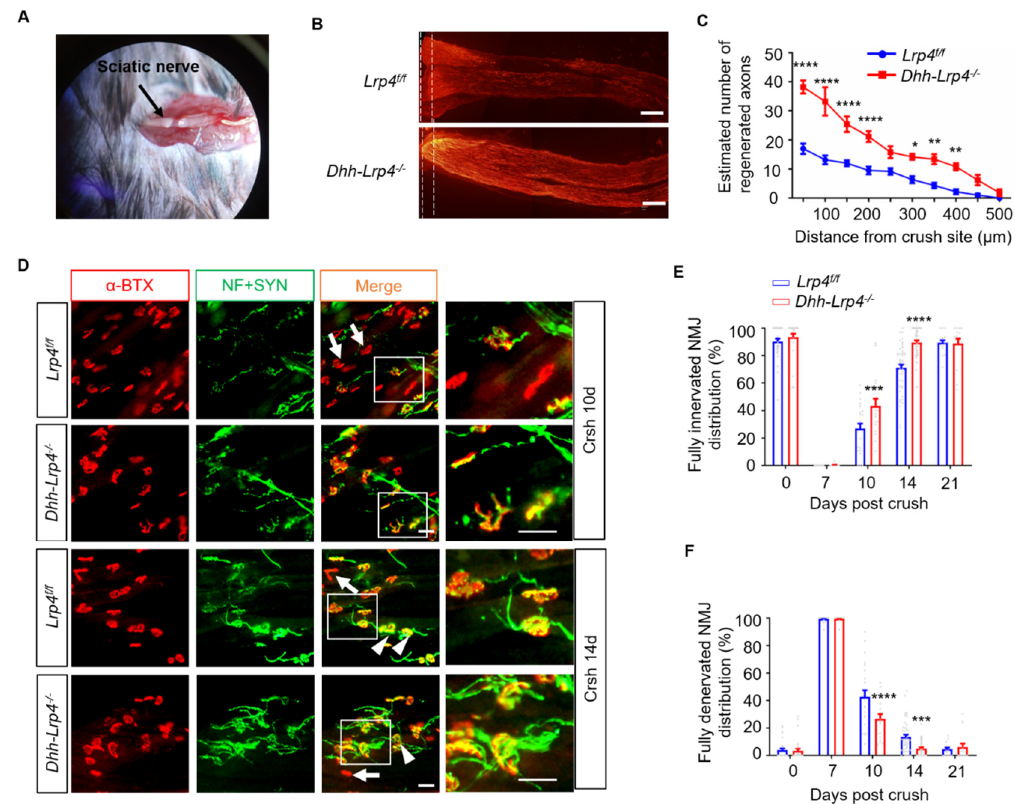
Figure 2. Ablation of Lrp4 in SCs promotes nerve regeneration. ( A ) Representative images of the sciatic nerve after crush surgery. ( B ) Biotin staining of sciatic nerve sections from cKO mice revealed more regenerated axons at 7 dpc. Scale bar = 200 μ m. ( C ) The regenerated axons were longer in the cKO mice than in the control mice. **** p < 0.0001, ** p < 0.01, * p < 0.05, control, n = 6 slices; cKO, n = 5 slices, 3 mice/group. ( D ) Representative images of NMJ regeneration at 10 and 14 dpc. The arrowheads indicate fully reinnervated NMJs. The arrows indicate denervated NMJs. Scale bar = 50 μ m. ( E ) Quantification of the fully reinnervated endplates at 0, 7, 10, 14, and 21 dpc. Control mice (26.9 ± 3.6% and 71.0 ± 2.4% at 10 and 14 dpc, respectively) display fewer reinnervated NMJs at 10 and 14 dpc than the cKO mice (43.4 ± 5.0% and 89.4 ± 1.5% at 10 and 14 dpc, respectively). *** p < 0.001, **** p < 0.0001, control, n = 33, 26, 23, 50, and 18 slices at 0, 7, 10, 14, and 21 days, respectively. cKO, n = 27, 22, 18, 50, and 16 slices at 0, 7, 10, 14, and 21 days, respectively. Three or four mice per group. ( F ) The fully denervated NMJs were reduced in cKO mice (26.7 ± 3.5% and 5.0 ± 0.9% at 10 and 14 dpc, respectively) 10 and 14 dpc compared with the control mice (42.6 ± 4.9% and 13.5 ± 1.5% for 10 and 14 dpc, respectively). **** p < 0.0001, *** p < 0.001, 3 or 4 mice per group. All the data are presented as mean ± SEM.